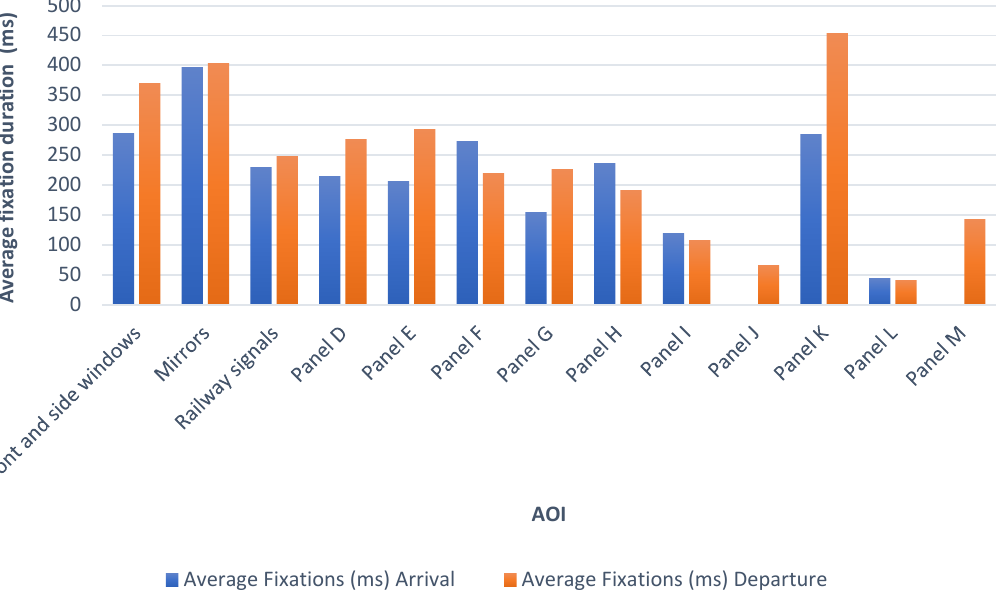
Figure 9. The comparison of the average fixation duration between arrival and departure proce- dures.